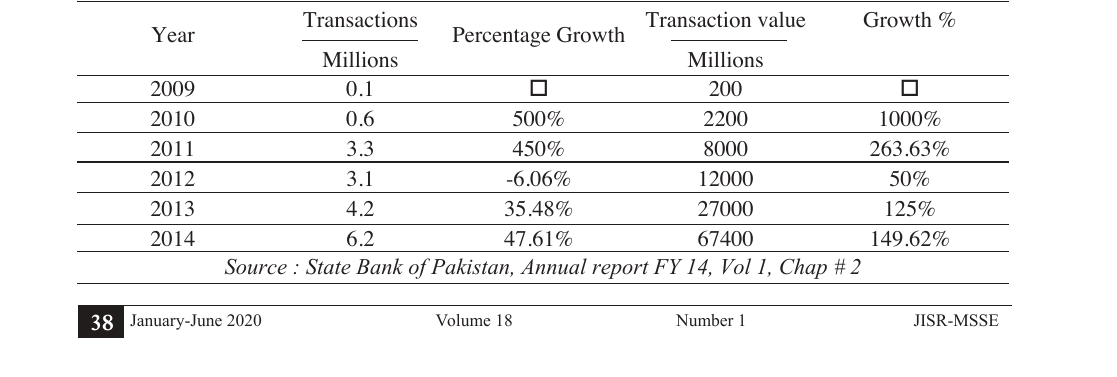
MB Trend in Pakistan (Arshian Sharif,